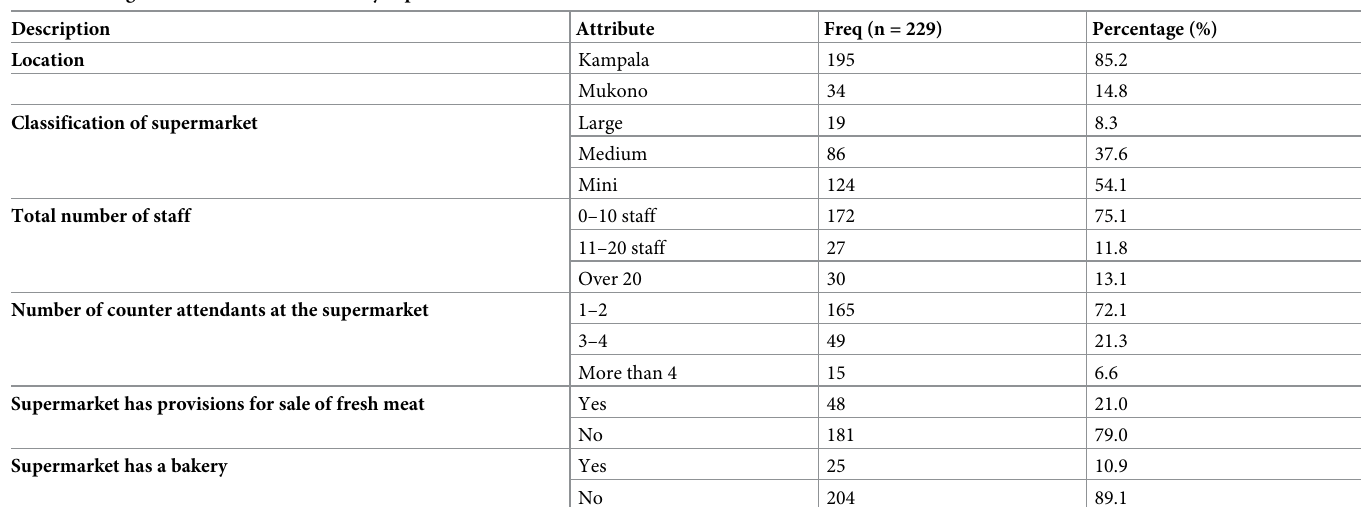
Table 1. Background characteristics of study supermarkets.